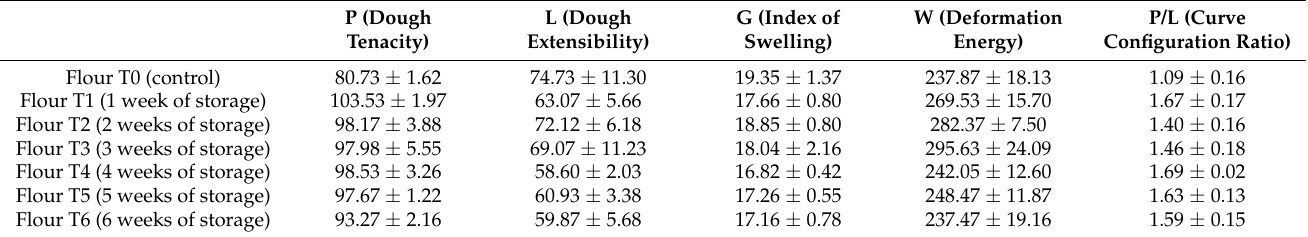
Table 3. Results of alveograph tests (mean of five measurements (diskettes) for each proof) expressed as the mean of the three replicates ±